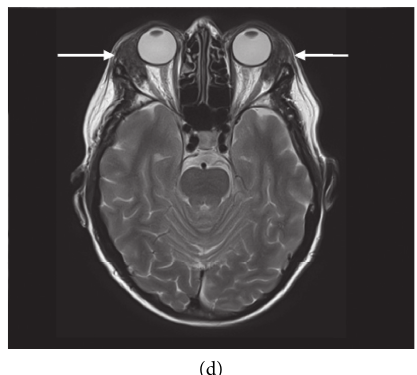
Figure 20: Primary amyloidosis. A 64-year-old woman with known primary amyloidosis of lacrimal glands, initially presenting with neck pain. Sagittal T2 (a), T1 (b), and axial T2FS (c) spine shows an infiltrative process involving the C7 and T1 vertebrae with an extraosseous extension of soft tissue into the epidural and prevertebral spaces (arrow). End plate irregularity is also present. Axial T2FS (c) at the level of C7 demonstrating epidural and prevertebral soft tissue infiltration (arrow). This case was difficult to distinguish from infection, ultimately requiring a biopsy for the final diagnosis of C7/T1 amyloid deposition. Axial T2 head at the level of the orbits (d) showed bilateral lacrimal gland enlargement secondary to amyloid deposition (arrow).